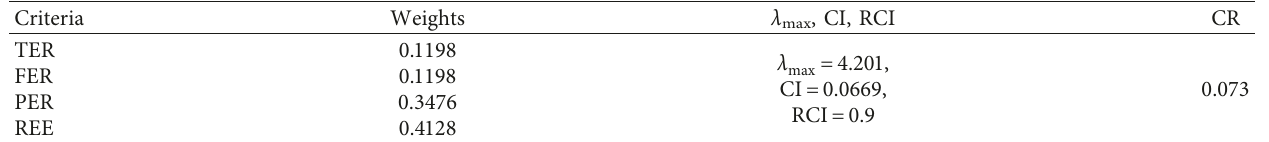
Table 10: Results obtained with FAHP.